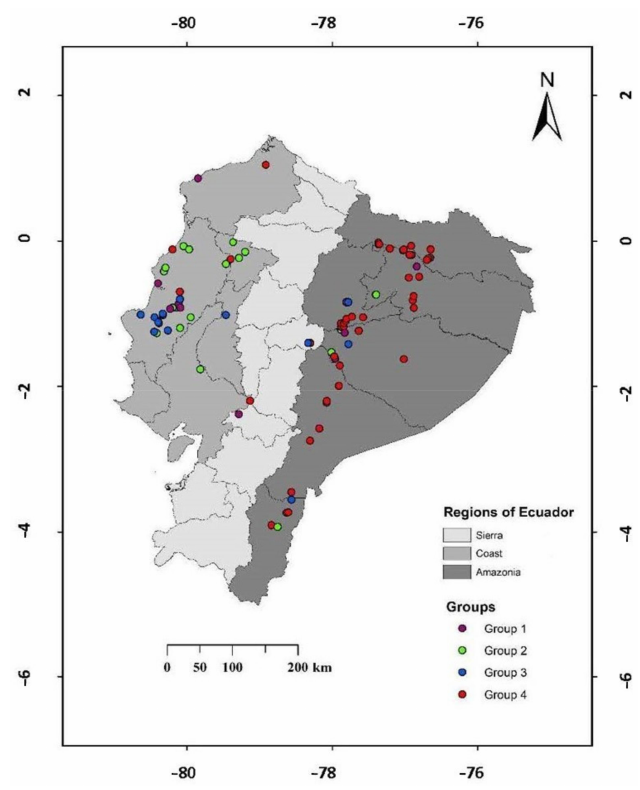
Figure 2. Distribution of 199 cassava accessions collected in Ecuador. The three continental Ecuado- rian regions and morphological grouping within the regions—Figure 1—are colored accordingly. Using the ECOGEO tool of the CAPFITOGEN program [31], the ecogeographic char- acterization was carried out using 55 ecogeographic variables (Supplementary Table